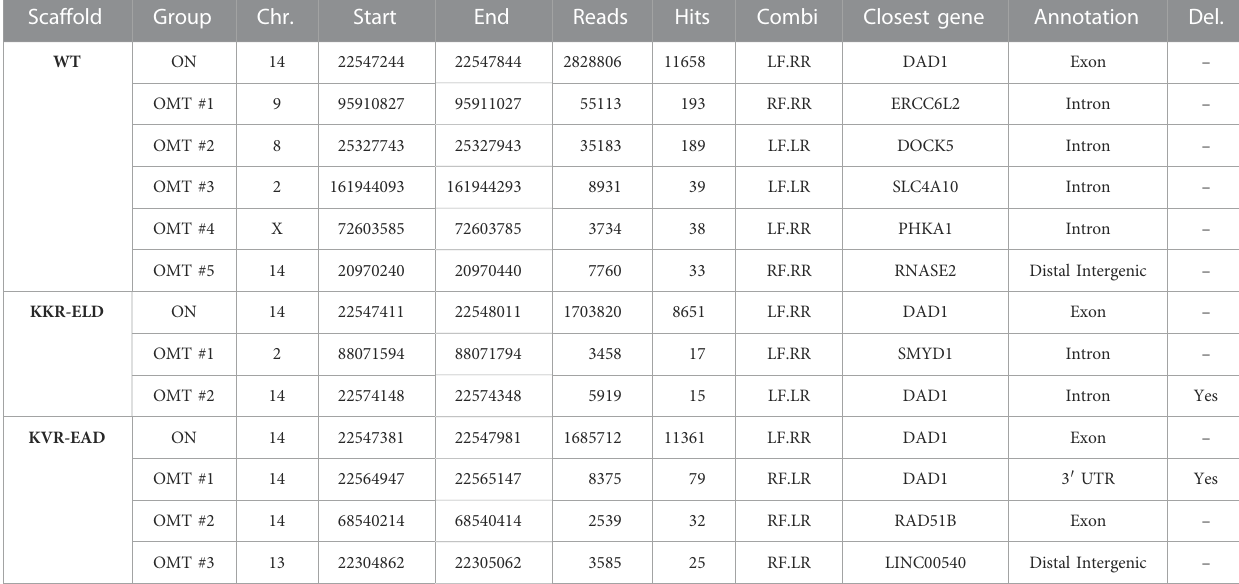
TABLE 4 T-CAST results for TRAC -targeting wild type and OH-TALEN.Listed are OMTs with > 20hits or the two top scoring OMTs (KKR-ELD) and NBSs with > 40hits. TALEN combinations: LF, left TALEN arm in forward orientation; LR, left TALEN arm in reverse orientation; RF, right TALEN arm in forward orientation; RR, right TALEN in reverse orientation. Large deletions (Del.) at the TRAC on-target site are speci fi ed. Scaffold Group